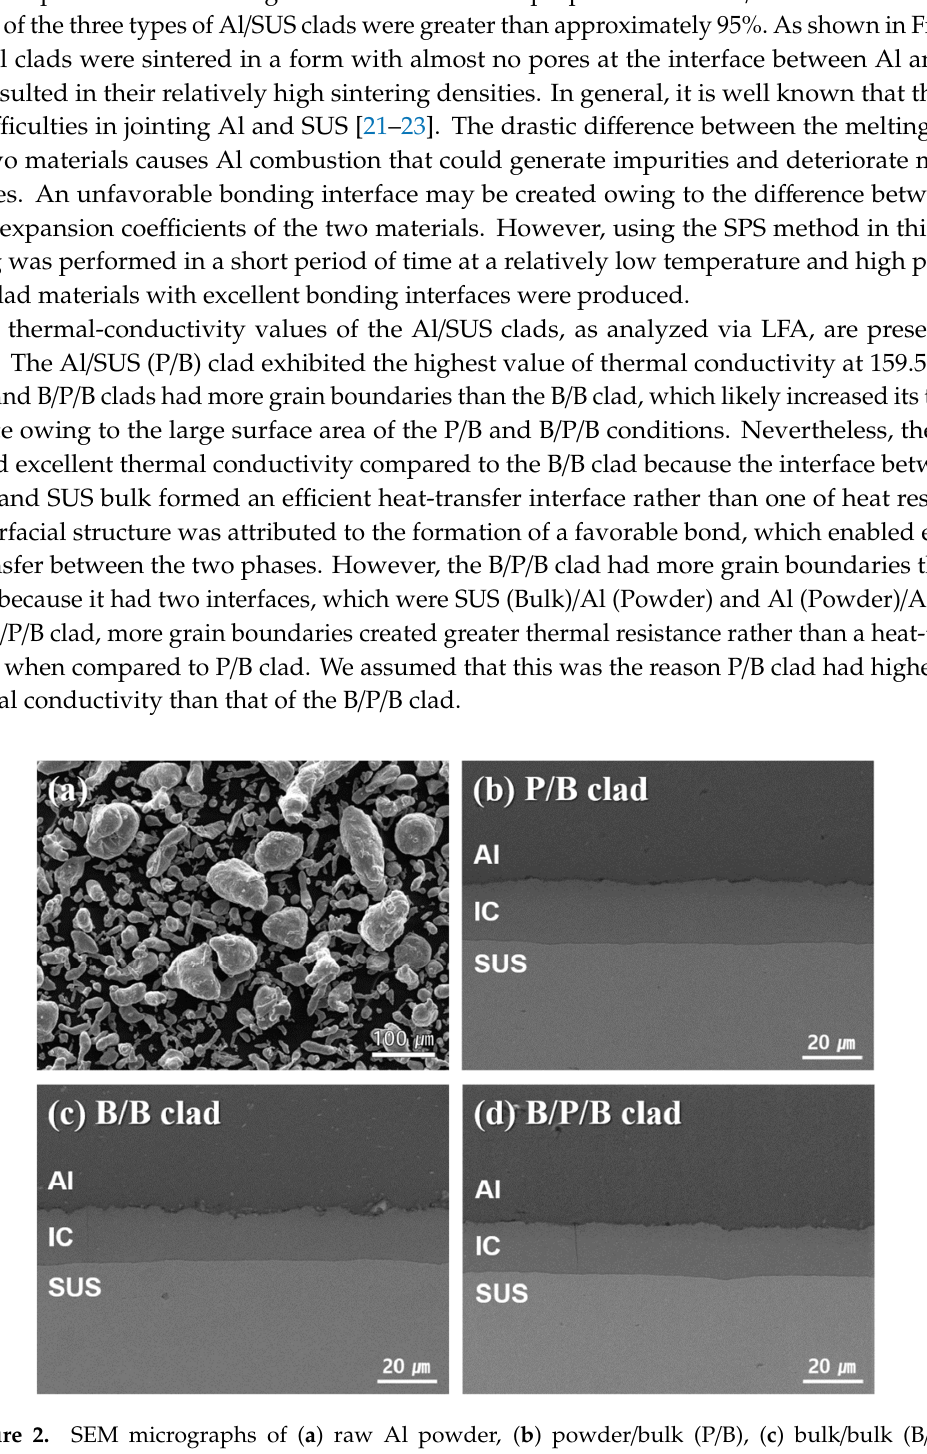
Figure 2. SEM micrographs of ( a ) raw Al powder, ( b ) powder/bulk (P/B), ( c ) bulk/bulk (B/B), and ( d ) bulk/powder/bulk (B/P/B) clads. IC, intermetallic compounds.